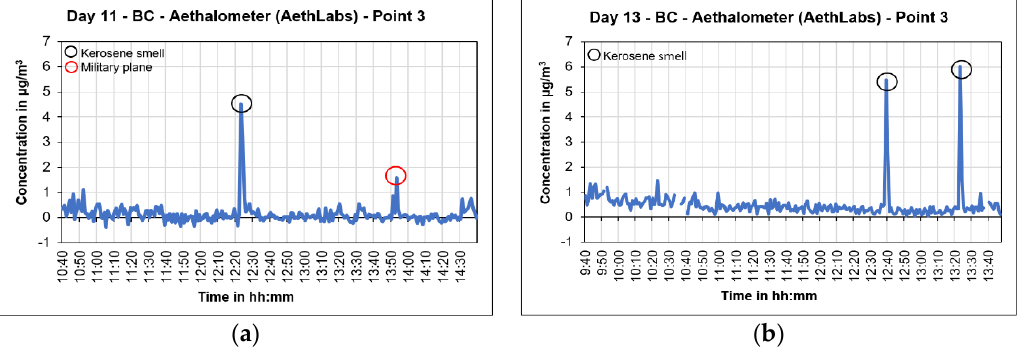
Figure 21. BC peaks on ( a ) day 11 and ( b ) day 13 at point 3.